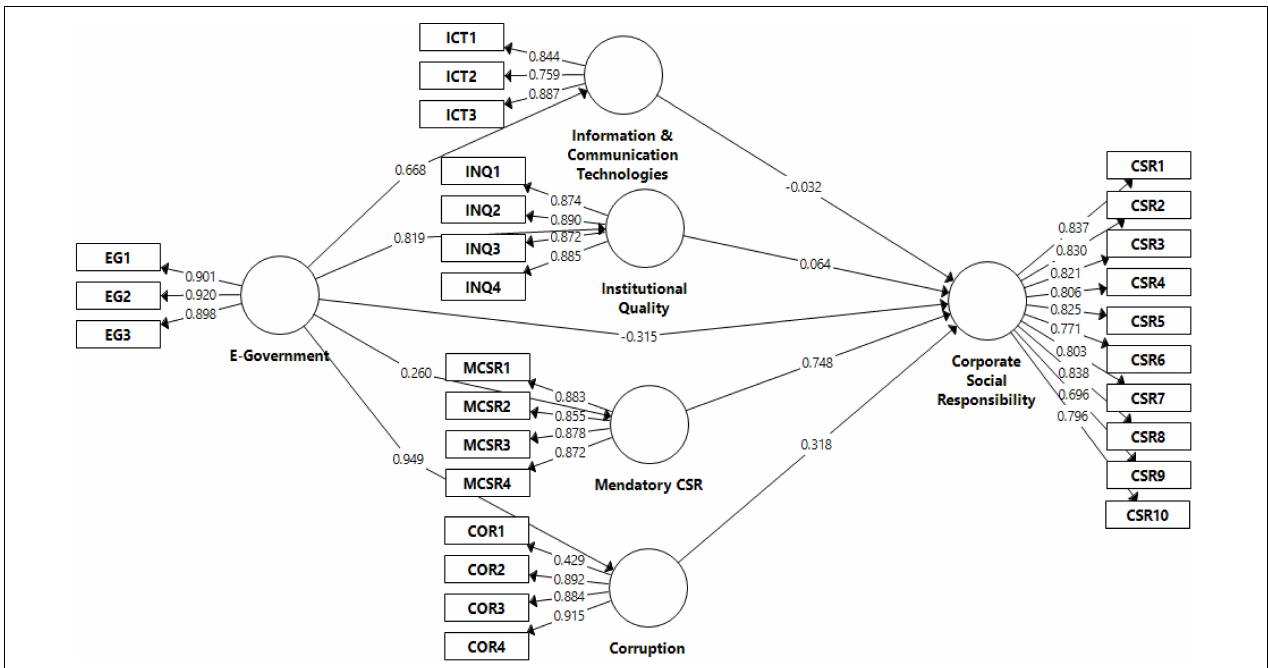
FIGURE 2 | Partial least square-algorithm for the measurement model.